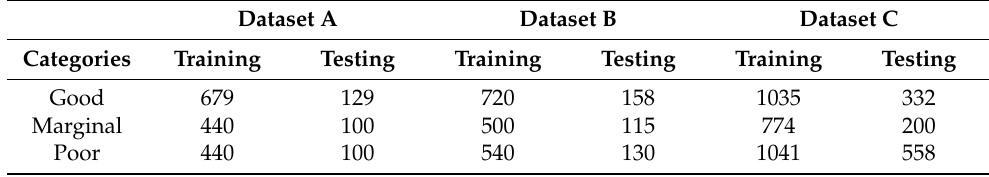
Table 1. Number of segmented images for respective categories and datasets.